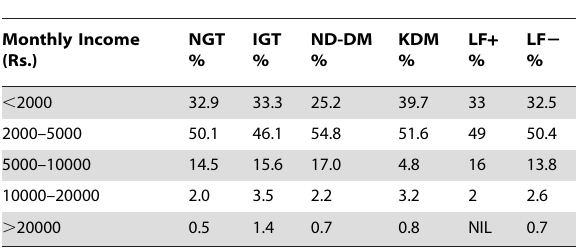
Table 2. Socioeconomic status of study subjects*.